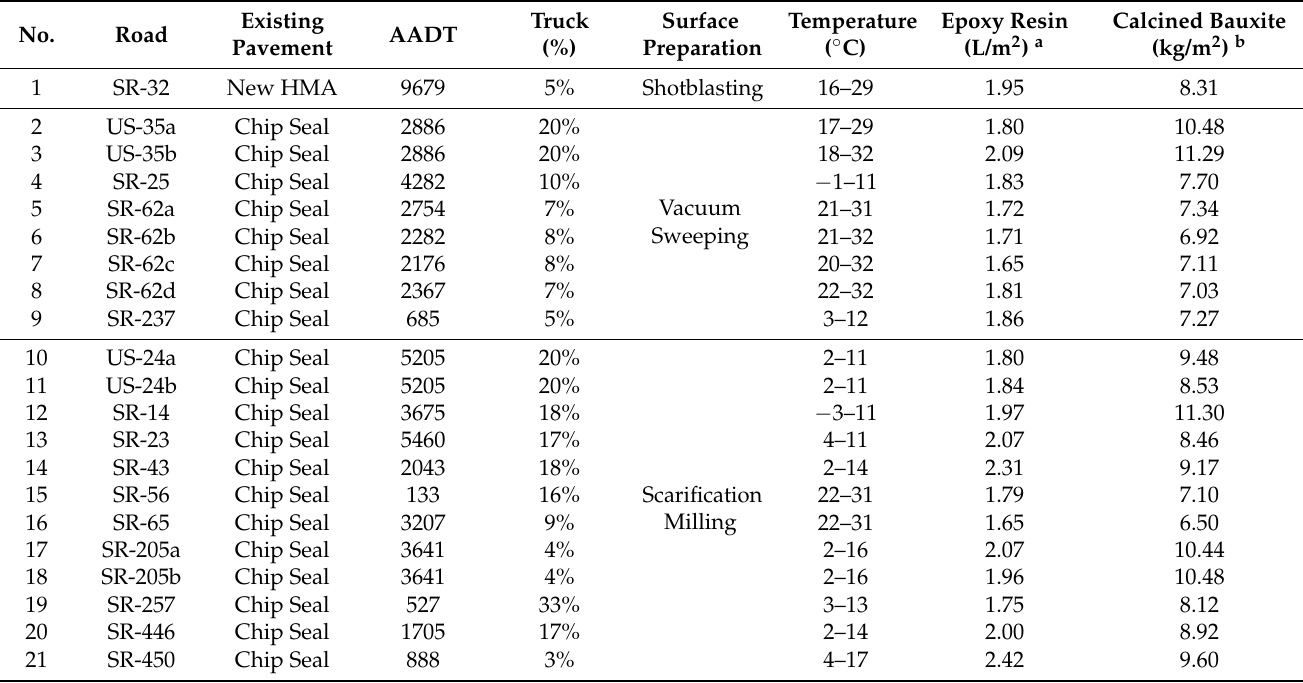
Table 3. Information for road, traffic, pavement, and construction at HFST